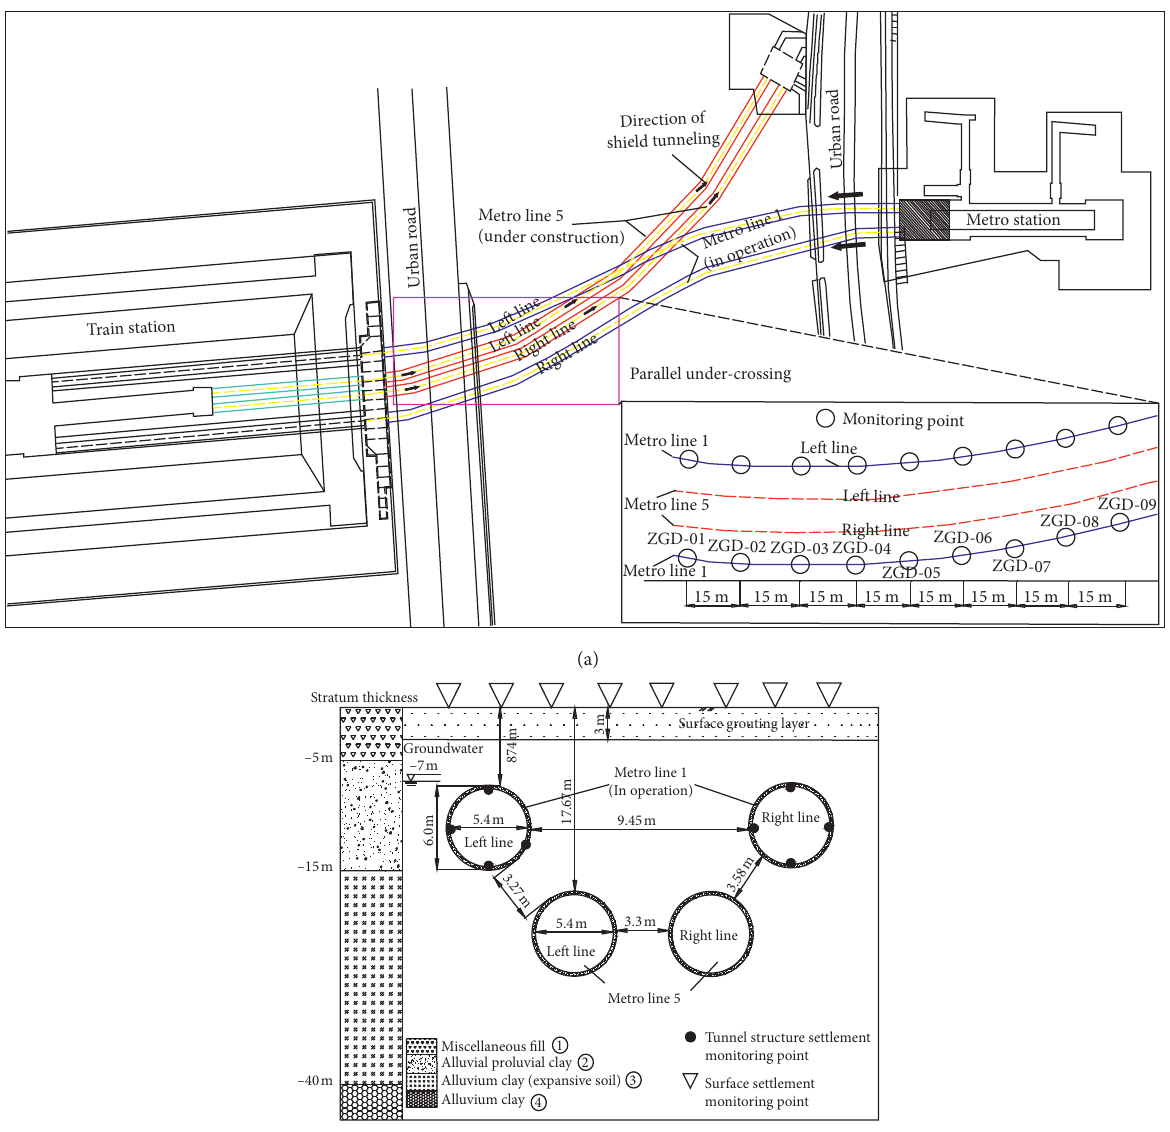
Figure 1: Plan and spatial location of subway tunnels of lines 1 and 5. (a) Plan position of tunnel and layout of monitoring points. (b) Spatial location of